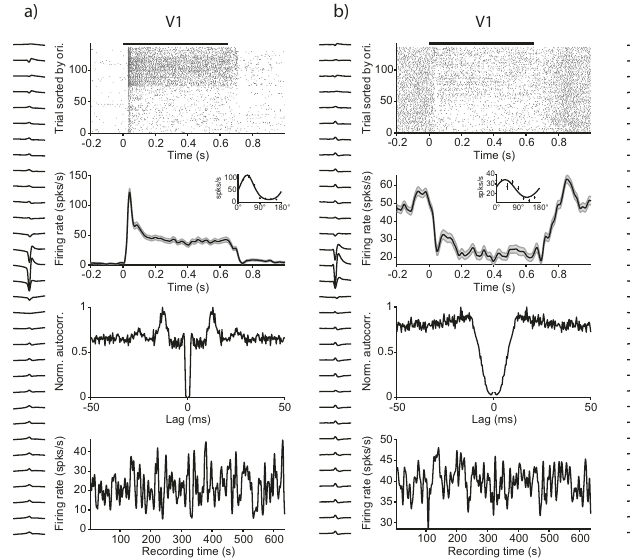
Fig. 6 | Single-unit examples from areas V1 and V6. Examples of four visually modulated single units ( a – d ). The left side of each column shows the mean wave- form across all 32 recording sites of the electrode shank on which the largest absolute amplitude was detected. Top row: spiking raster plot around the time of visual stimulation. Trials are sorted by orientation condition. Black bar on top indicates stimulus duration (0.65s). Second row: trial-averaged and smoothed (Gaussian window, σ =10ms) peristimulus time histogram (PSTH). Inset shows orientation tuning curves calculated from the mean activity during the stimulus